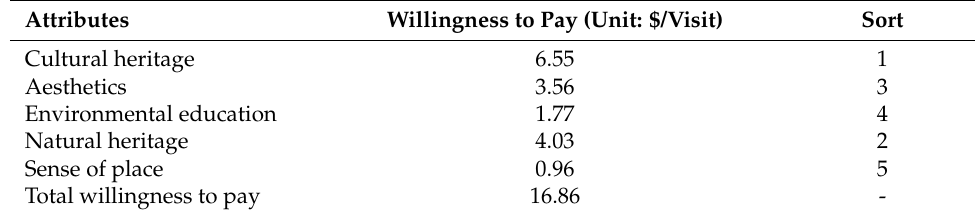
Table 7. Recreational value of each